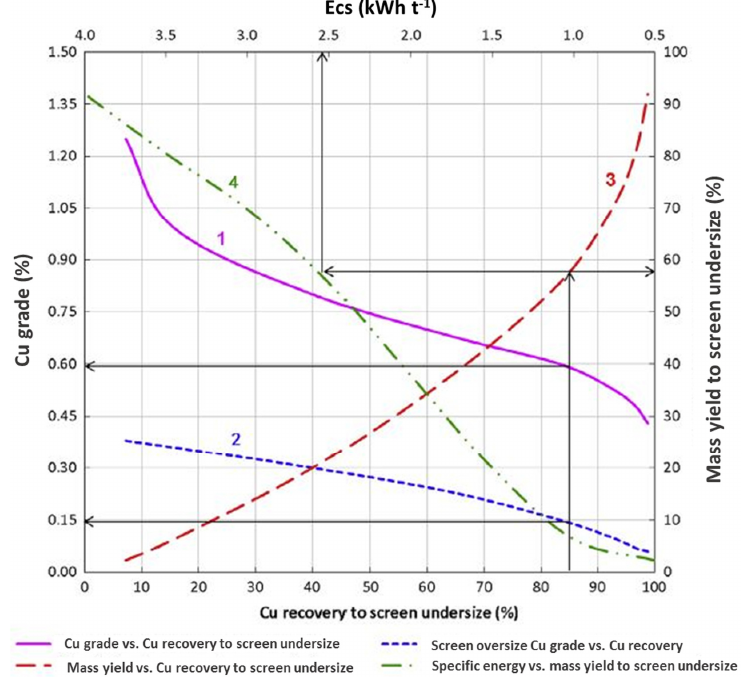
Figure 30. Proposed electrical pulse preconcentration characteristics curves [161].